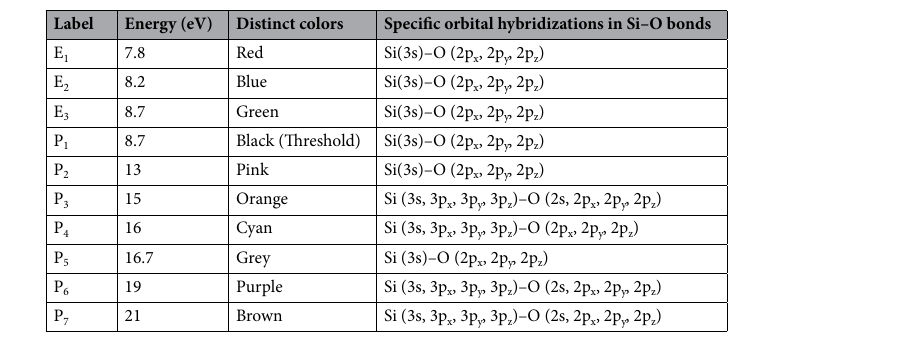
Table 1. Prominent absorption structures: Frequencies, colored indicators and identified orbital hybridizations with and without electron–hole interaction in Si–O bonds.